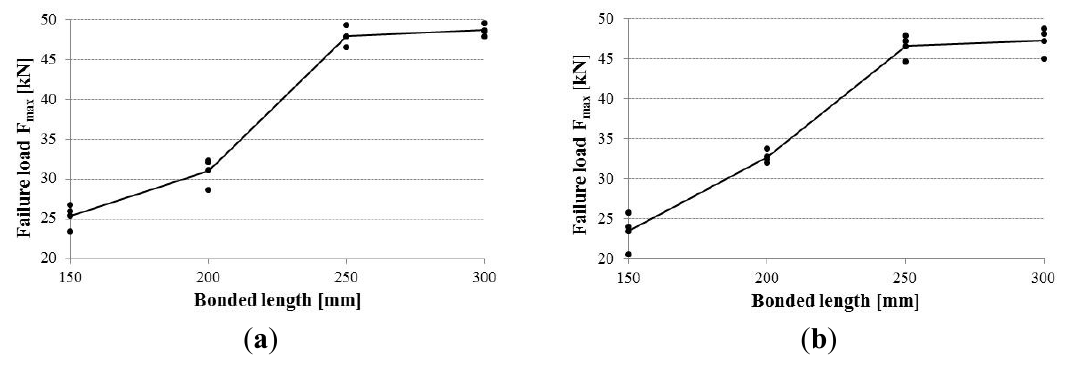
Figure 9. Failure load (pull-out capacity) vs . bonded length: ( a ) chestnut wood; ( b ) fir